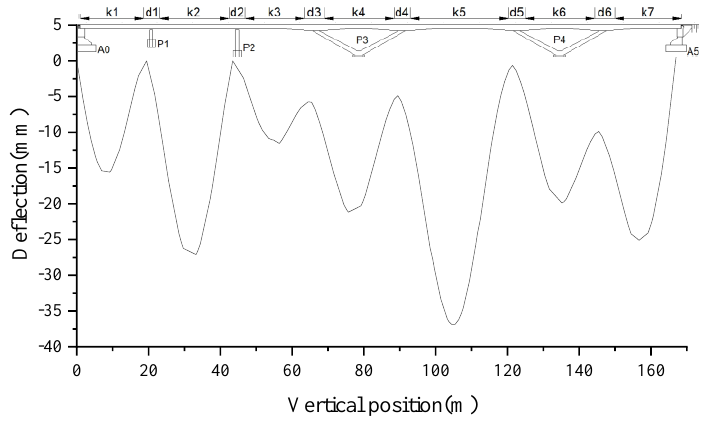
Figure 16. Schematic diagram of full bridge deflection.